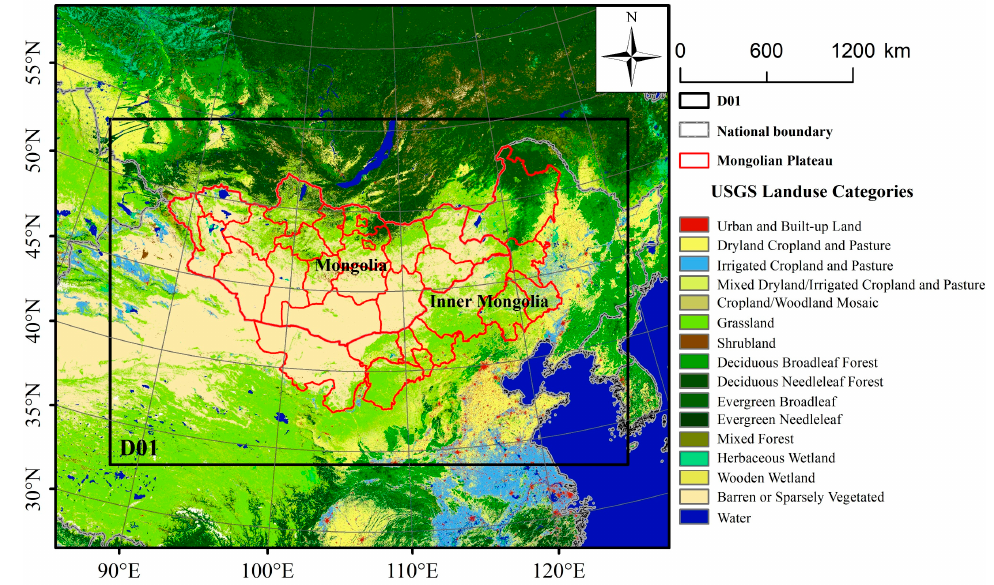
Figure 1. Location of study area, simulation domain (D01), and the land use pattern.